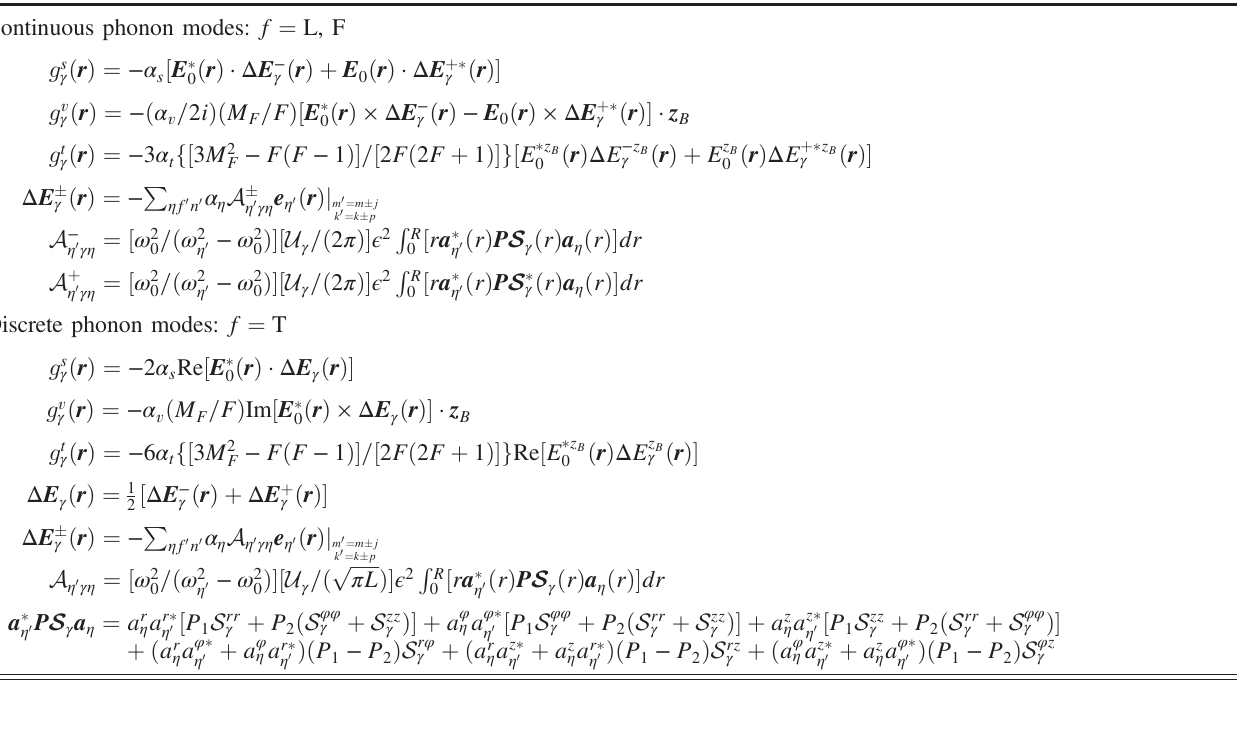
TABLE XVI. Atom-phonon coupling functions due to strain in a nanofiber-based atom trap. The coupling functions correspond to scalar, vector, and tensor light shift induced by a single monochromatic light field of frequency ω 0 and complex field profile E 0 . All symbols are defined in Appendixes A, C, and D. In particular, the photon mode indices are η ¼ ð m; f; k; n Þ as defined in Eq. (A15), and the phonon mode indices γ ¼ ð j; f; p; n Þ as defined in Eq. (C27). The index η designates an unperturbed eigenmode, while the primed index η 0 labels modes perturbatively populated due to strain.